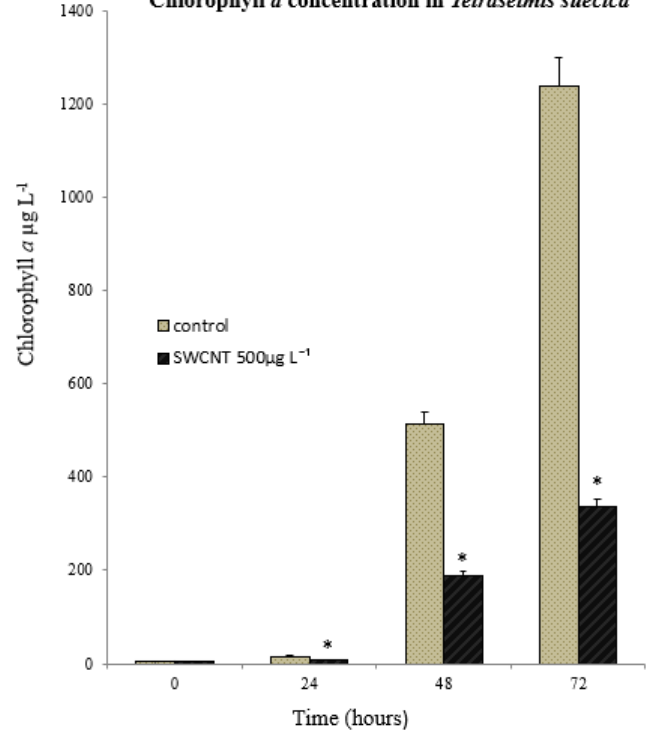
Figure 4. A. Raman spectrum of Algal-SWCNT interaction, ( A ) Magnification ( × 20) of algal cells exposed to 500 µ g L − 1 single-walled carbon nanotubes (SWCNTs) for 24 h. The white circle in the center of ( B ) marks the position of the Raman excitation beam spot, which was focused to a diameter of 1.7 µ m. A representative Raman spectrum was acquired from SWCNT stock, algae cells spiked with 500 µ g L − 1 SWCNT for 24 h ( A ). The spectrum was collected using a 50 × , 0.75 numerical aperture microscope objective lens. The spectrum clearly shows the characteristic of (red peak) SWCNTs stock and (black peak) algal cells exposed to 500 µ g L − 1 SWCNTs: radial breathing mode at 268 cm − 1 , D band at 1290 cm − 1 , G band at 1590 cm − 1 , and G’ band at 2585 cm − 1 .